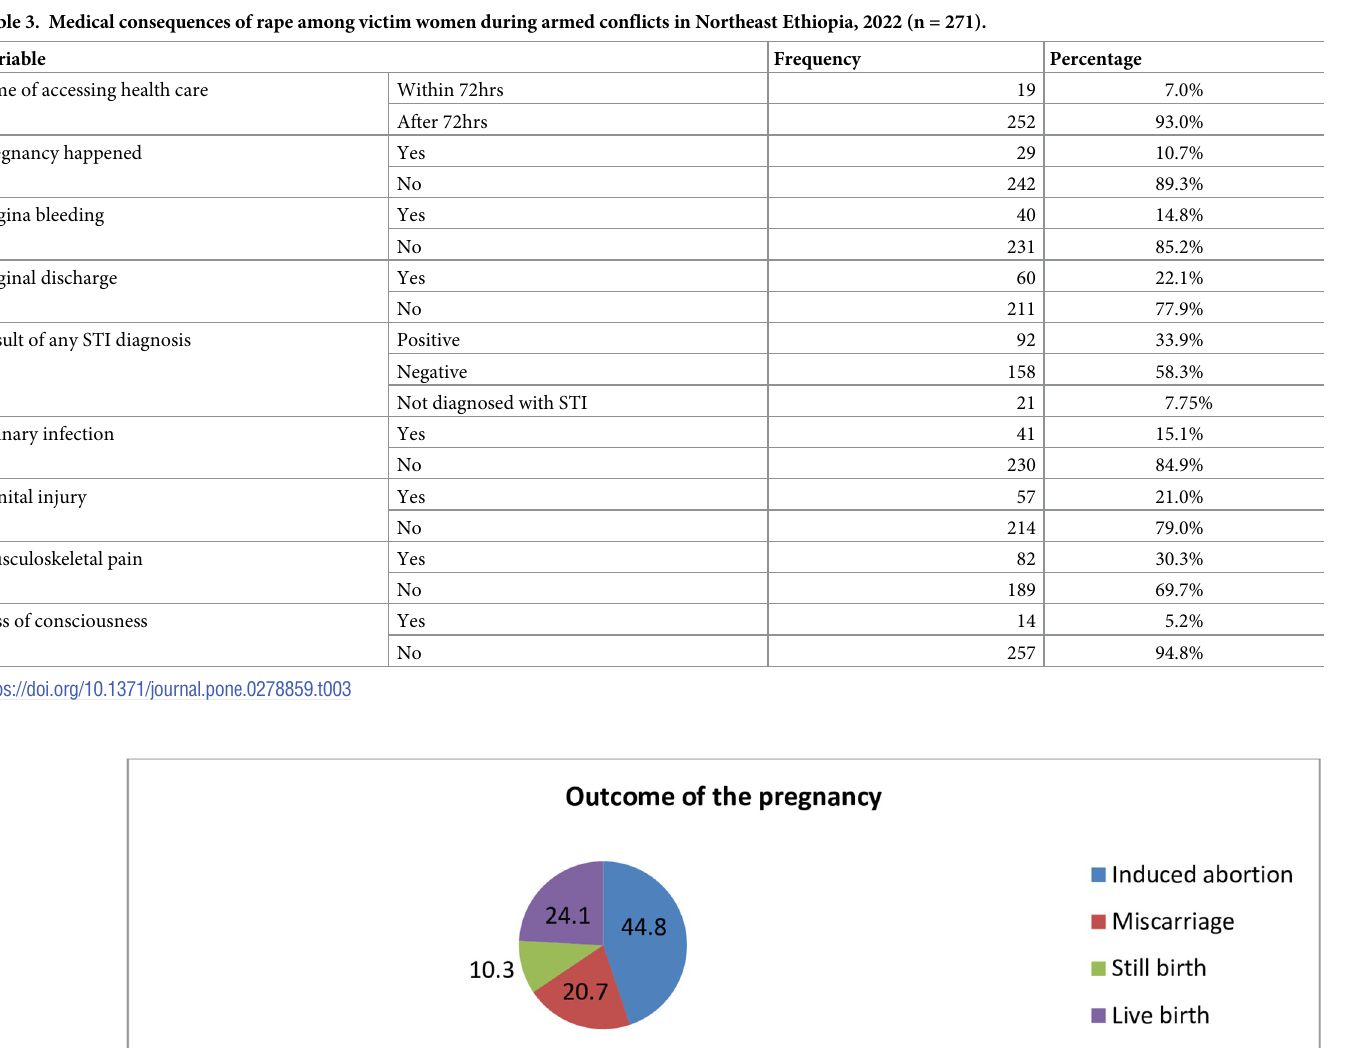
PLOS ONE | https://doi.org/10.1371/journal.pone.0278859 December12,